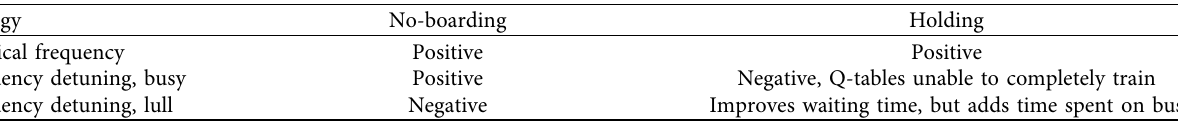
Table 1: Qualitative performance of the no-boarding and holding strategies, respectively, in various setups of N � 2 buses serving M � 12 bus stops in a loop.